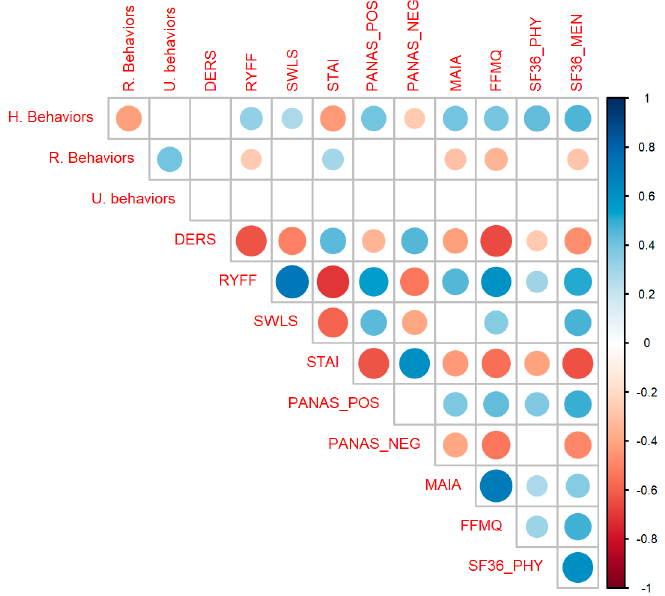
Figure 3. Correlation matrix between all variables. Healthy Behaviors (HB) significantly correlates with almost all psychological scales as expected (positively with well-being and interoceptive variables and negatively with anxiety and negative affect). Circles represent significant correlations after correcting for multiple comparisons. Colors blue and red indicate positive and negative values of r, respectively. The size of the circles and the intensity of each color represents the magnitude of the correlation. Abbreviations: STAI, State Trait Anxiety Inventory; RYFF, Ryff Well-being Scale; DERS, Difficulties in Emotional Regulation Scale; SWLS, Satisfaction with Life Scale; PANAS_POS, Positive and Negative Affect Scale, subscale Positive; PANAS_NEG, Positive and Negative Affect Scale, subscale Positive; SF36_PHY, Short Form Health Survey, subscale Physical; SF36_MEN,Short Form Health Survey, subscale Mental; FFMQ, Five Facet Mindfulness Questionnaire; MAIA, Multidimensional Assessment of Interoceptive Awareness Scale.